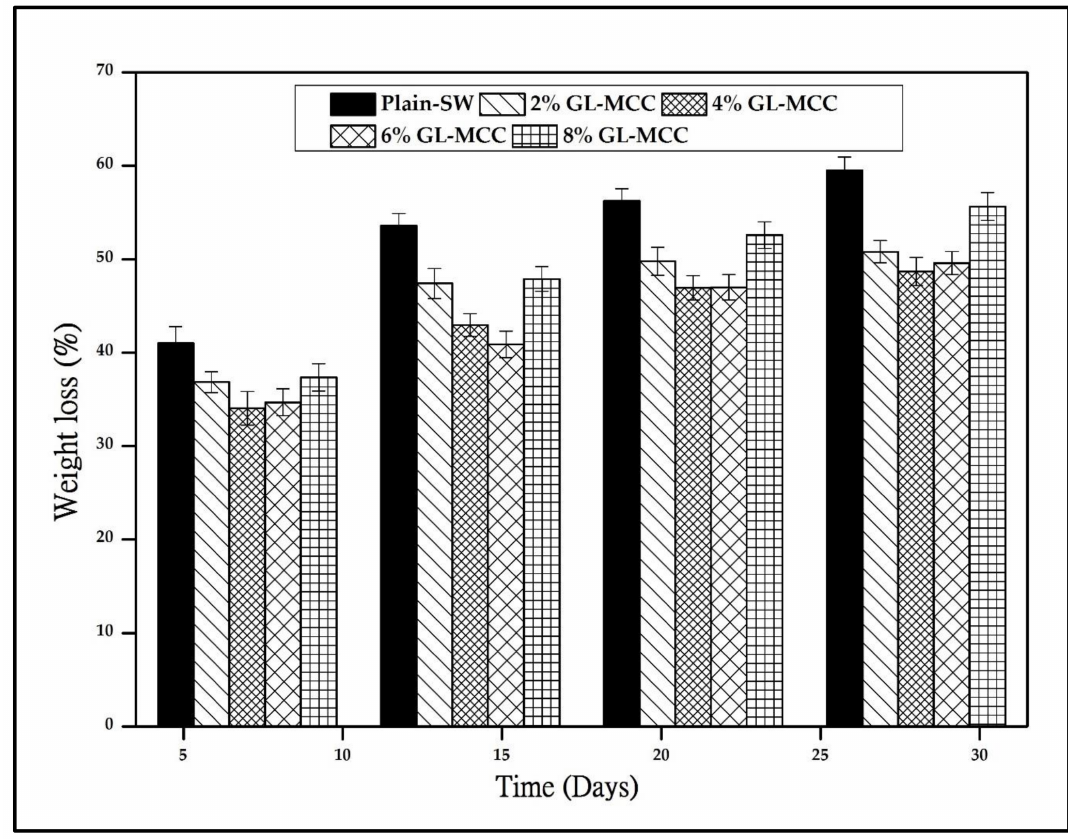
Figure 7. The mass reduction (%) of macroalgae (SW) / polysaccharide microfibre (GL-MCC) biopolymer